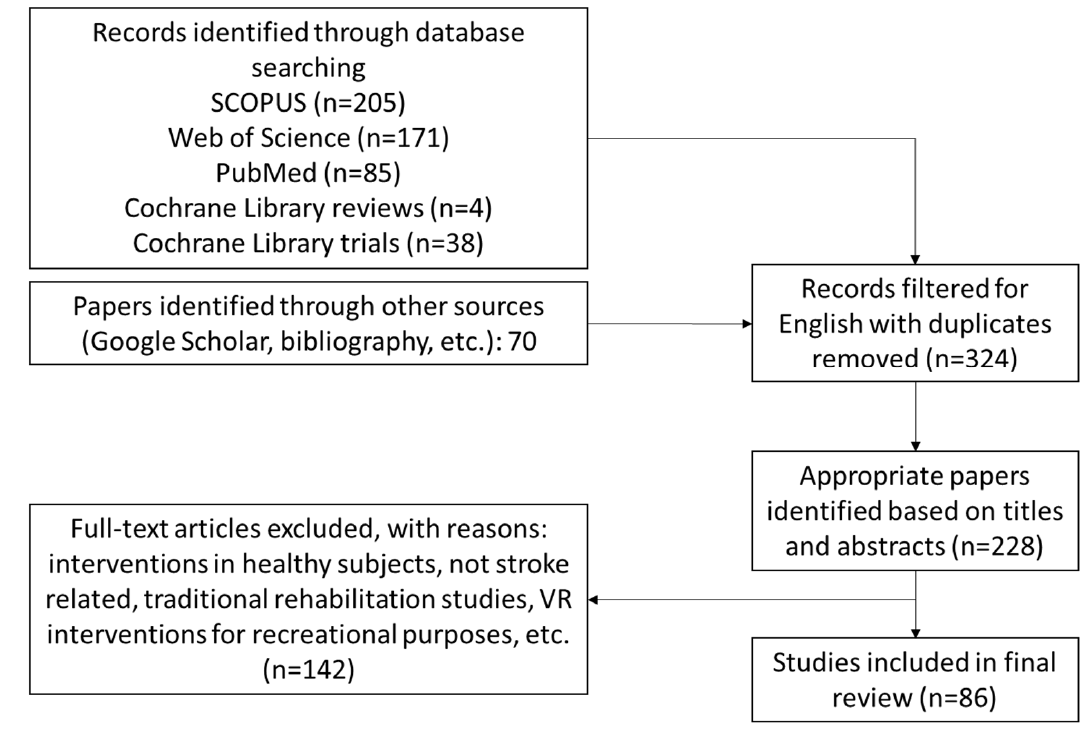
Figure 1. Review process diagram.